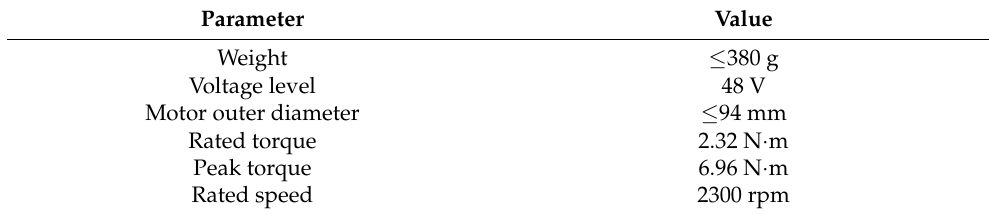
Table 2. The main performance requirements of